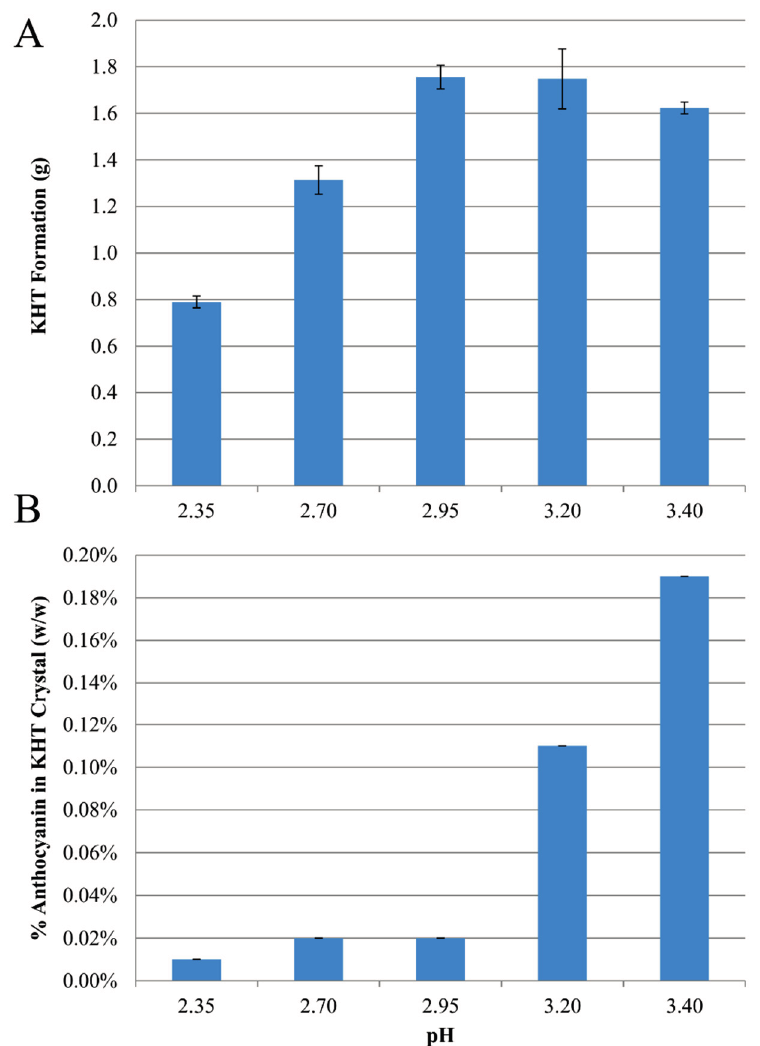
Figure 1. Effects of pH on ( A ) mass (g) of KHT crystals recovered by filtration after cold stabilization of blackcurrant model juices, and ( B ) total anthocyanin (% w/w) coprecipitating with KHT crystals recovered from cold stabilized blackcurrant model